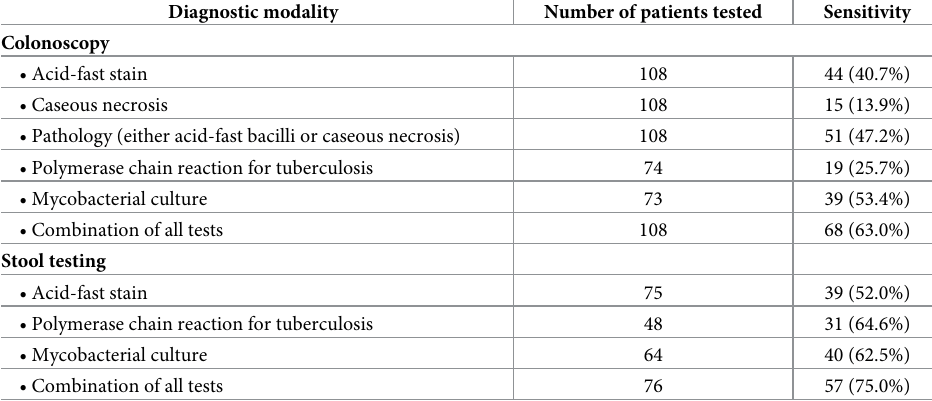
Table 2. The sensitivity of each diagnostic modality used to evaluate tissue biopsies obtained by colonoscopy and stool specimens for